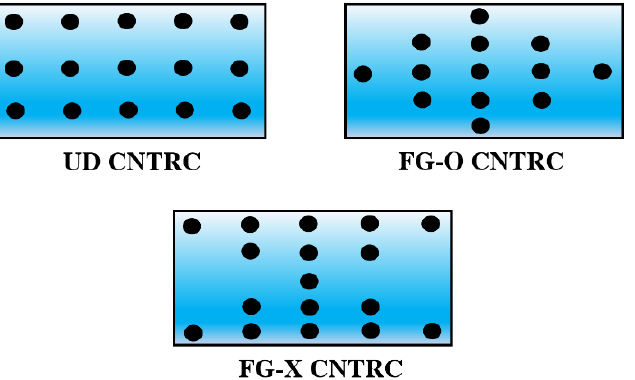
Figure 2. Cross-sections of various (CNTRC) carbon nanotube reinforced composite sandwich beams.